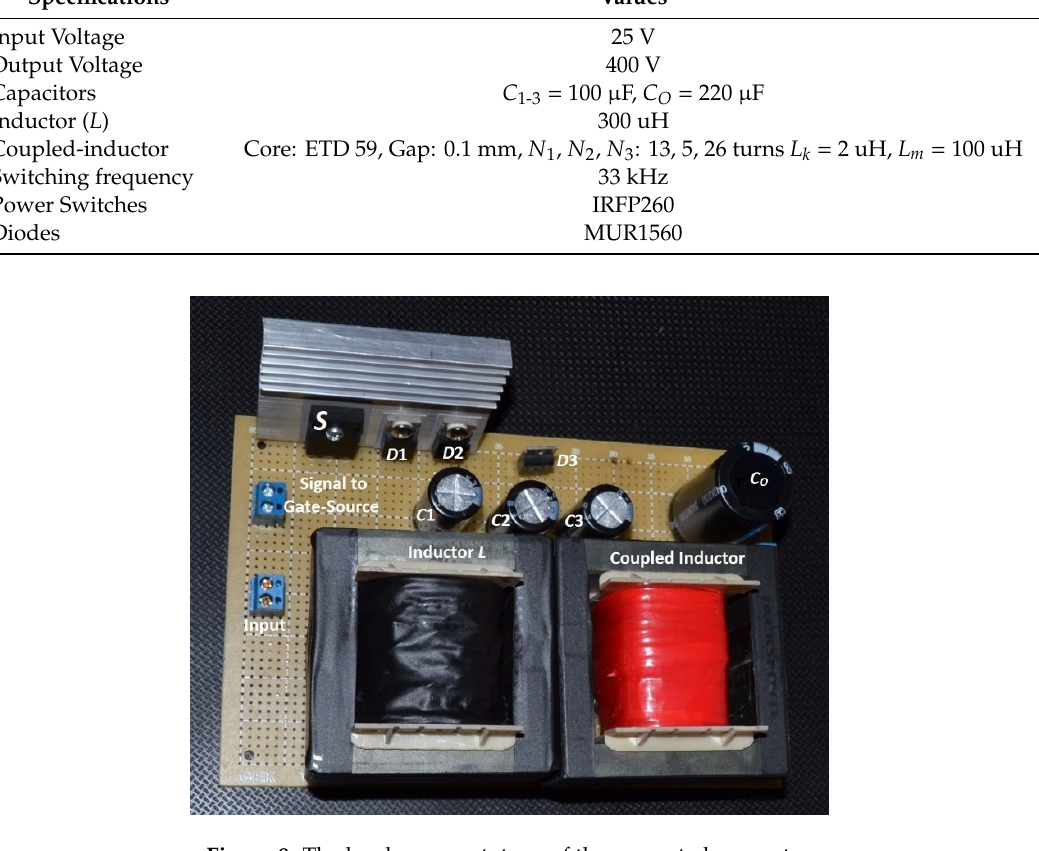
Figure 8. The hardware prototype of the presented converter. Table 2. The specifications of the implemented circuit.